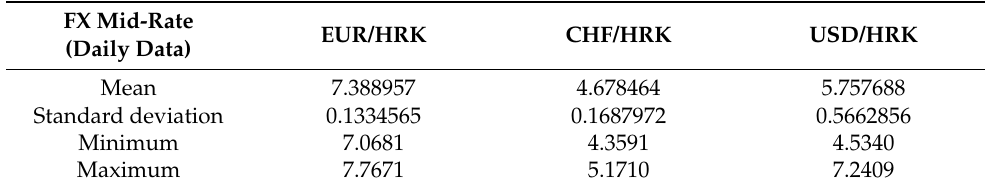
Table 8. Descriptive statistics of FX mid-rates, daily data for the 11 February 2003–31 December 2008